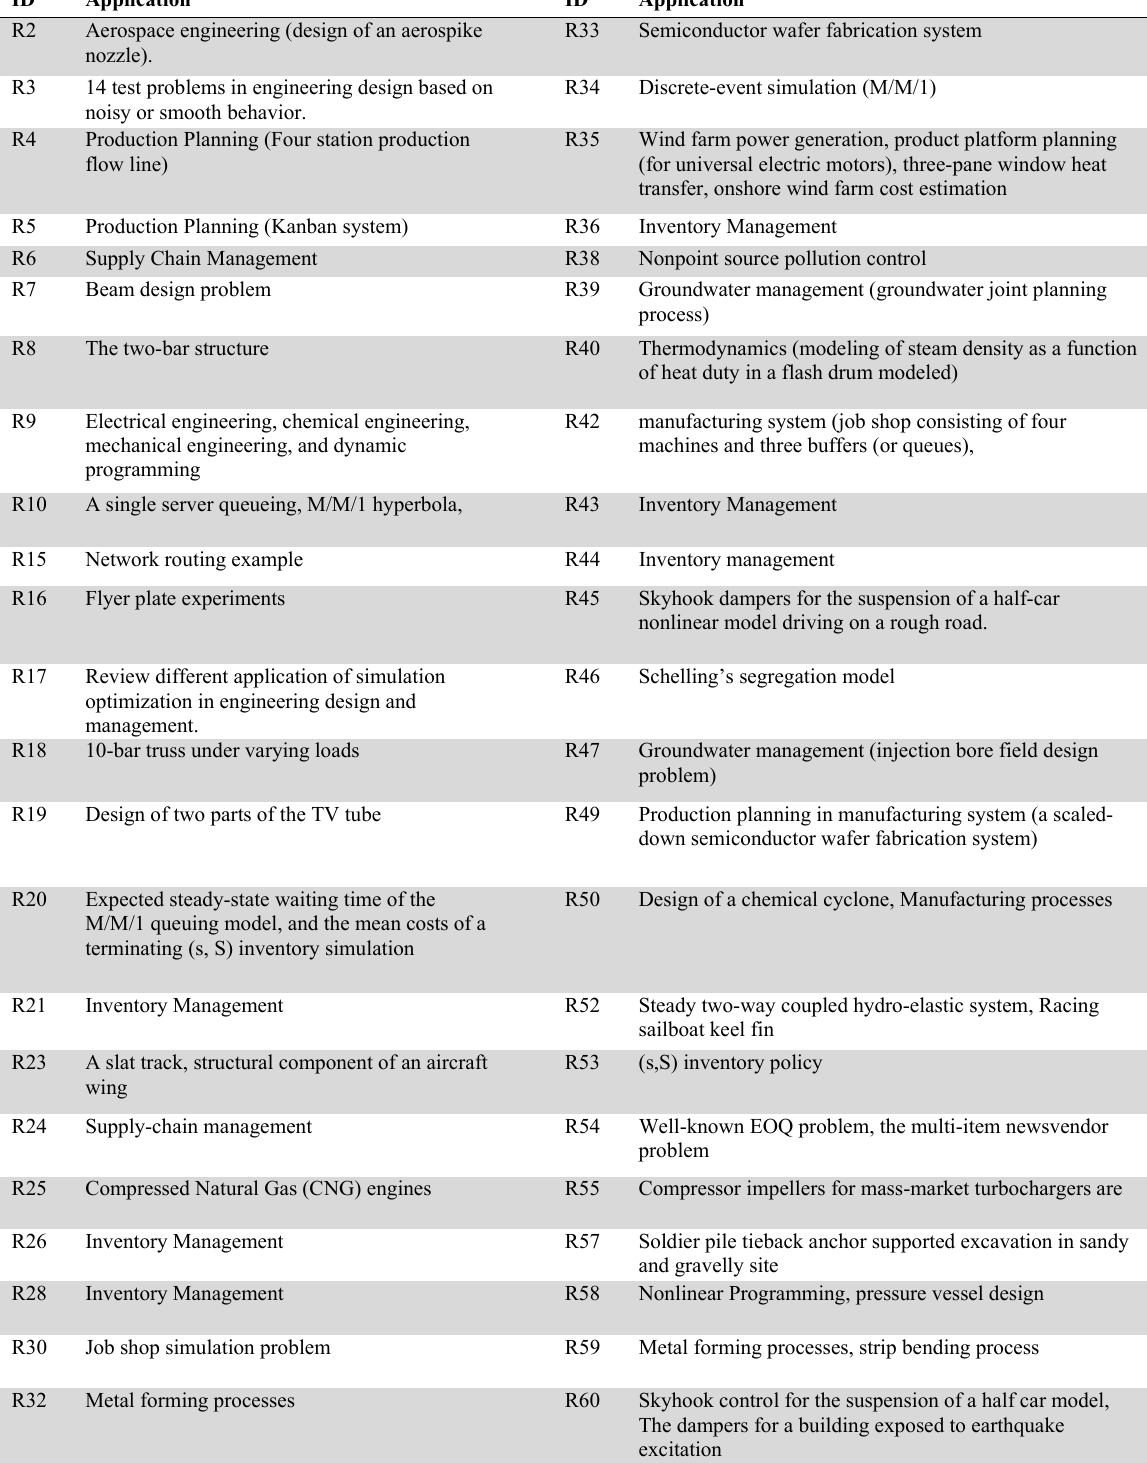
Application of SO (surrogate-based) in different engineering design and management